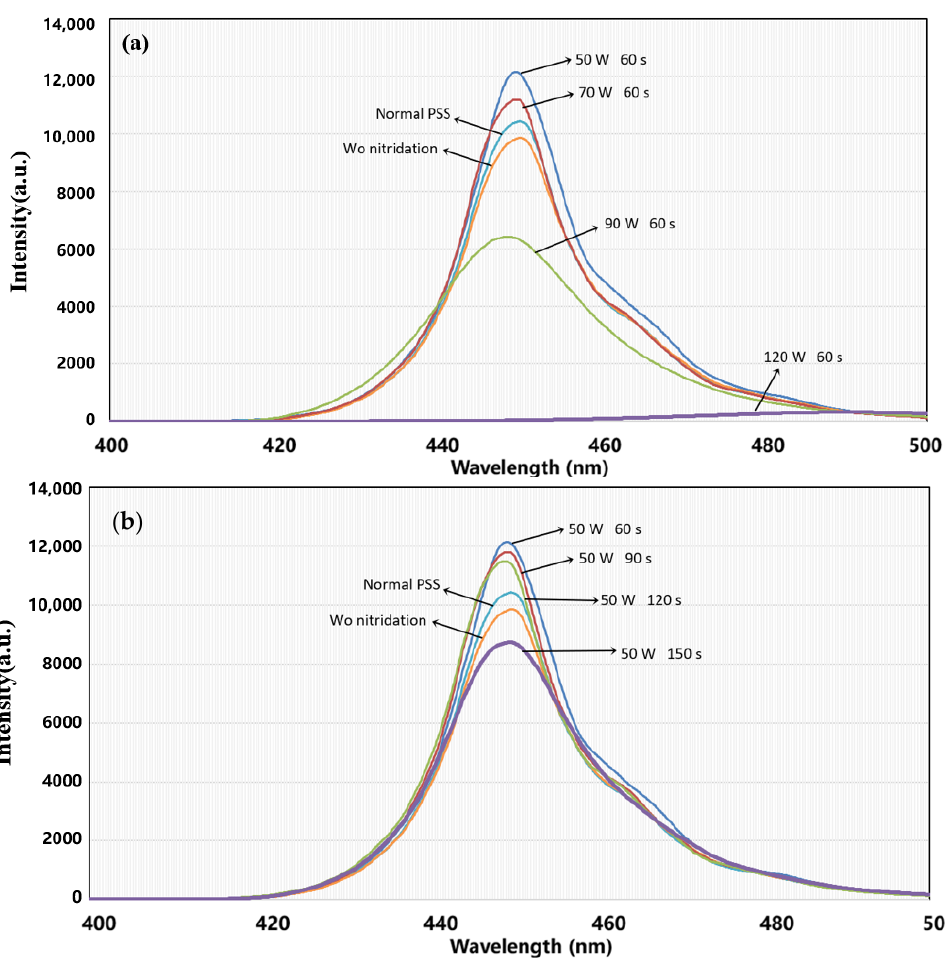
Figure 4. The PL spectra of the complete LED epitaxial structures classified by ( a ) the AC powers and ( b ) the nitridation times.